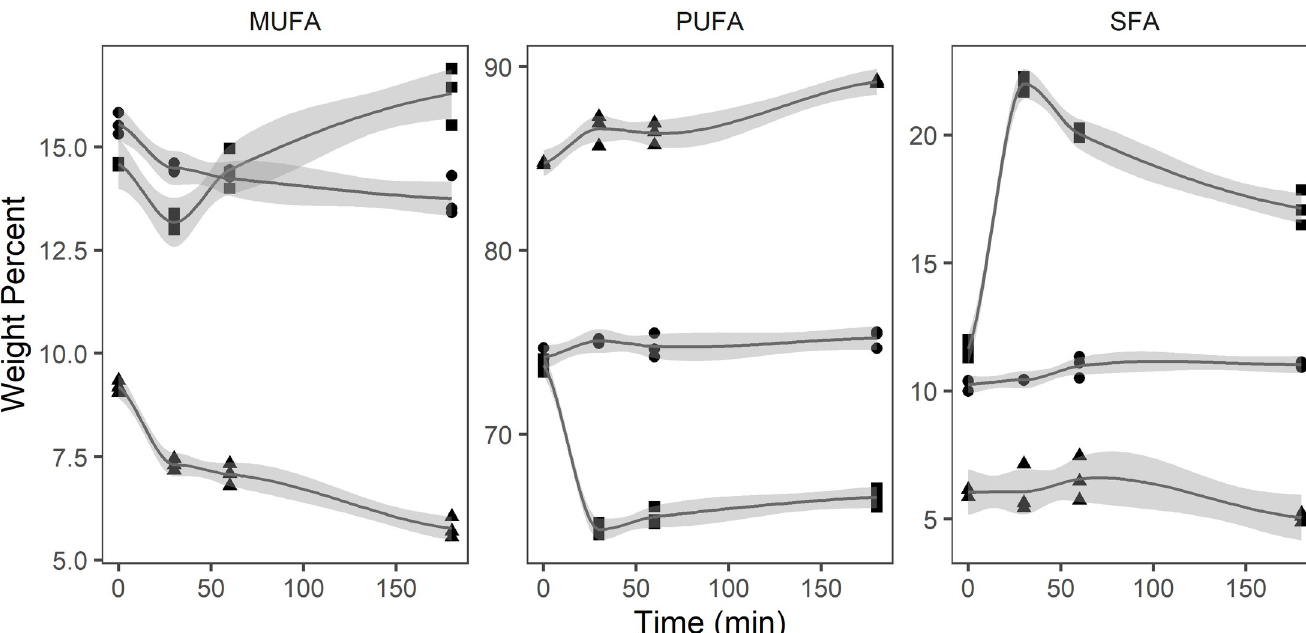
Fig 1. Monounsaturated fatty acids (MUFA), polyunsaturated fatty acids (PUFA), and saturated fatty acids (SFA) (weight percent) in free fatty acid (square), neutral lipid (circle) and polar lipid (triangle) fraction of oil from Porosira glacialis (n = 3) during in vitro digestion.